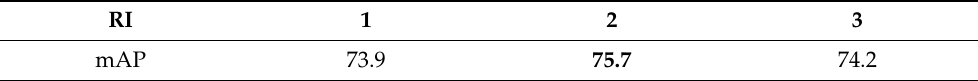
Table 6. Ablation study on recursive index. The best result is highlighted in bold. RI